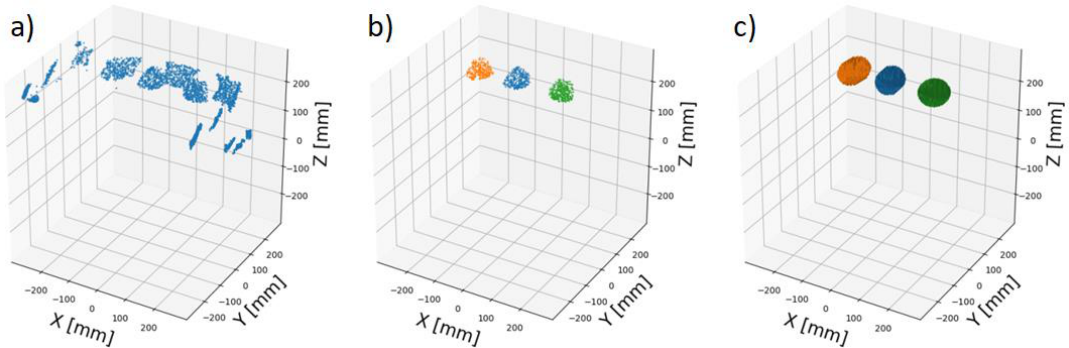
Figure 10. Processing steps: ( a ) Measured topography point cloud of the fermentation chamber inside; ( b ) Segmented dough pieces; ( c ) Model-fitted dough pieces.